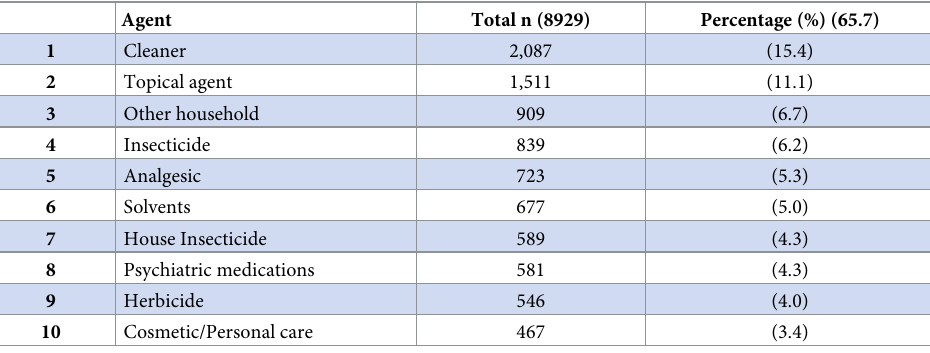
Table 3. Top 10 poisoning agents